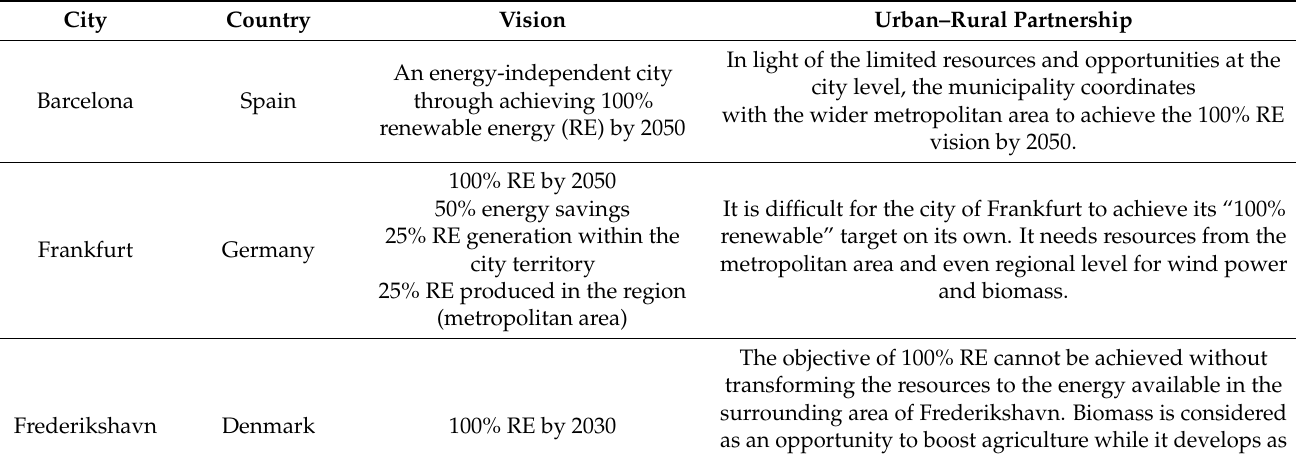
Table 2. Urban–rural partnership for achieving renewable energy target of selected